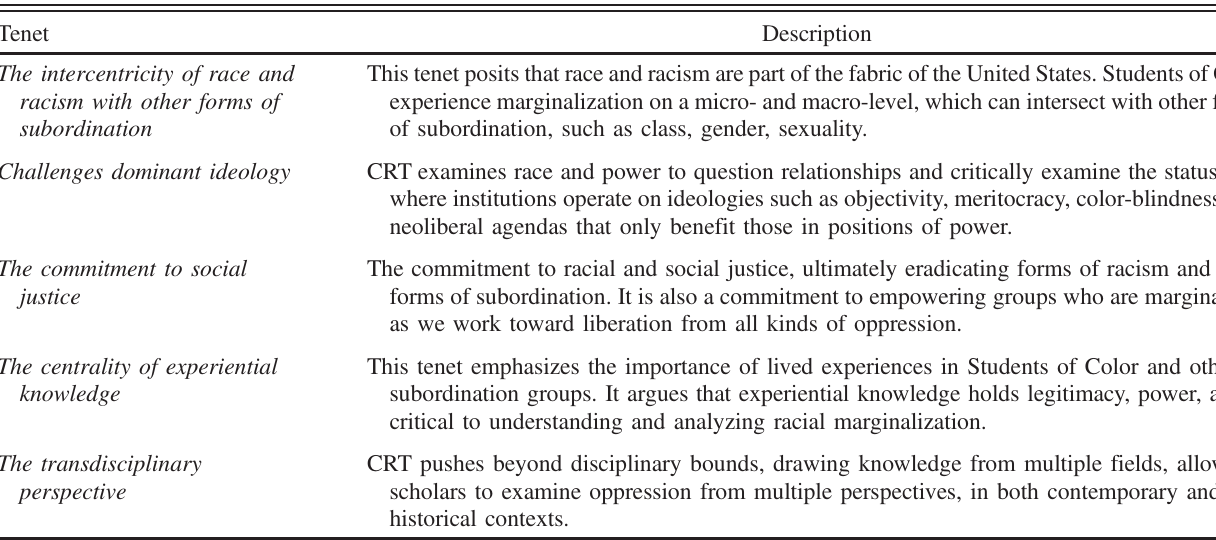
TABLE I. Tenets of critical race